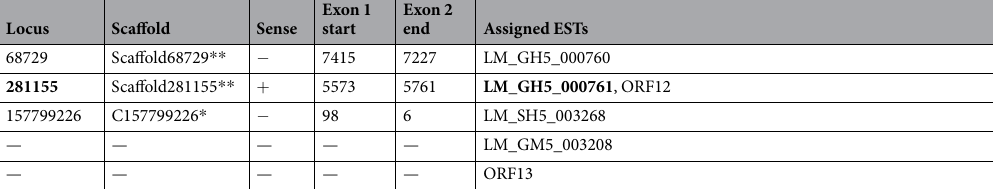
Table 1. Location of the putative CSPs in the scaffolds of L . migratoria ’s draft genome (version 2.4.1) and their best BLAST hit against the available ESTs from the same species. This table shows all the retrieved sequences (complete genes, orphan exons and ESTs whose loci are not sequenced yet). They all have positive BLASTx results against CSP proteins from the NCBI database. A sequence was considered to be a putative locust CSP if it had the conserved pattern of four cysteines (see the main text), was composed of two exons (1 and 2) belonging to the same scaffold and in the correct relative position and orientation. * The locus has more than one allele (see Tables S1 and S2 for additional BLAST data and further data on the attribution of ESTs to genomic loci and to known CSPs). In bold are the multi-allelic genes and the ESTs that had the best BLAST against them. In italic are the ESTs whose significant blast result did not pass the established sequence identity threshold (see Methods).